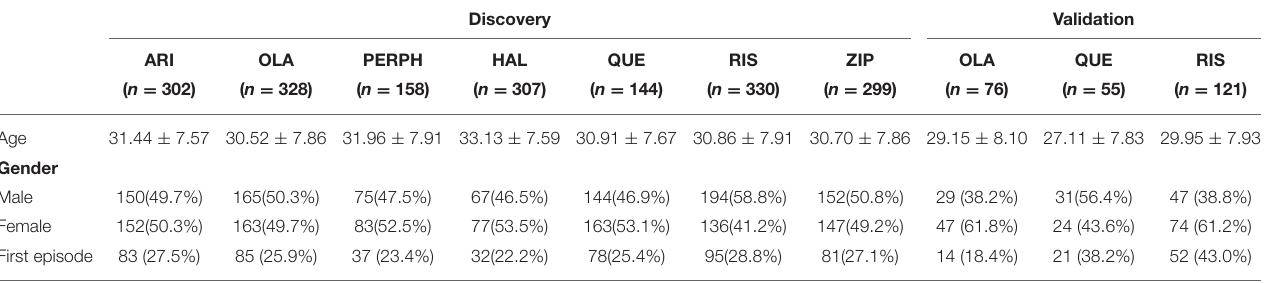
TABLE 1 | Demographic and clinical characteristics of discovery and validation samples. Discovery Validation